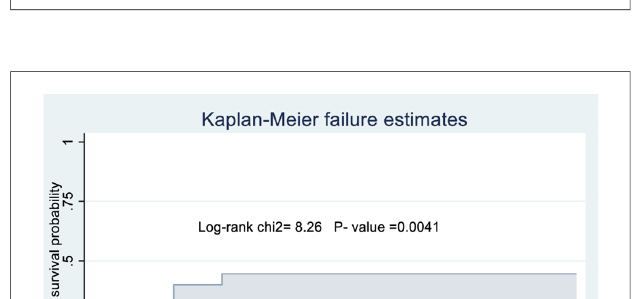
FIGURE 1 Kaplan-Meier curve showing the survival probability of developing puerperal sepsis.